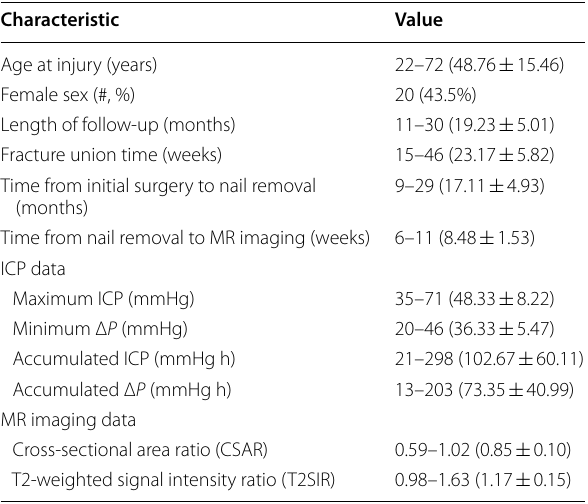
Table 1 Demographics of the patients who were recruited and